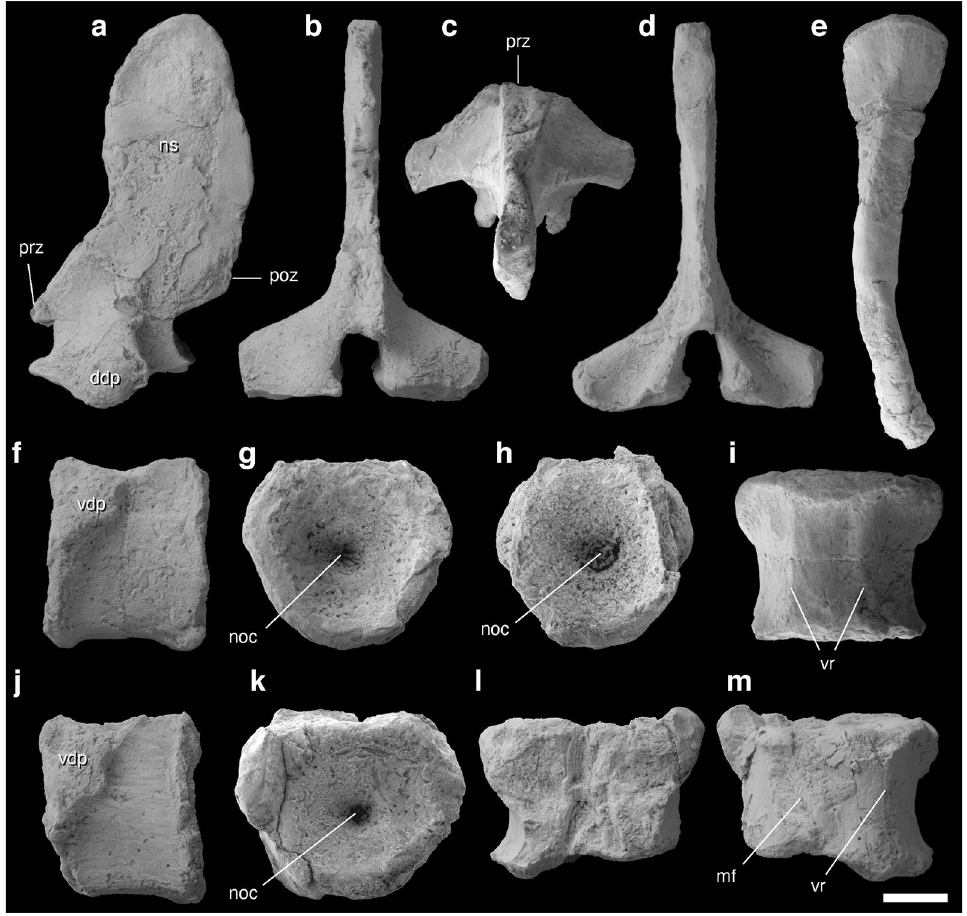
Figure 4. Axial elements of Ichthyopterygia gen. et sp. indet. NSM PV 23854 identified from a single concretion. (a–d) Neural arch in ( a ) left lateral, ( b ) anterior, ( c ) dorsal, and ( d ) posterior views. (e) Proximal portion of a rib in lateral view. ( f – i ) Centrum ‘A’ in ( f ) left lateral, ( g ) anterior, ( h ) posterior, and ( i ) ventral views. ( j – m ) Centrum ‘B’ in ( j ) left lateral, ( k ) anterior, ( l ) dorsal, and ( m ) ventral views. ddp dorsal half of diapophysis, mf microfault, noc notochordal canal, poz postzygapophysis, prz prezygapophysis, vdp ventral half of diapophysis, vr ventral ridge. Scale bar equals 1